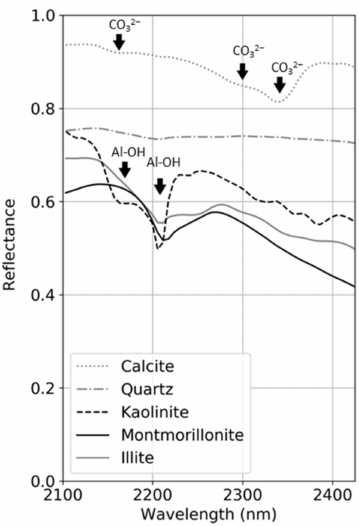
Figure 3. Spectral mean reflectance of illite, montmorillonite, kaolinite, quartz and calcite samples measured in the